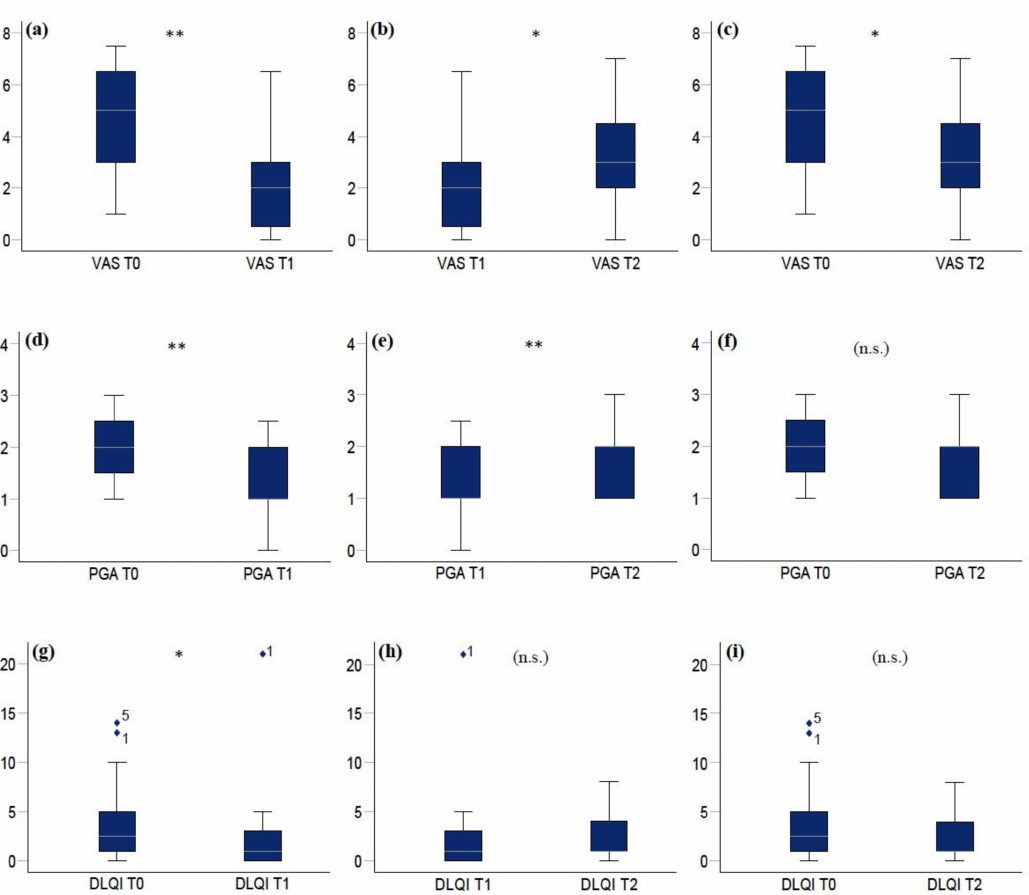
Figure 2. Boxplots depicting comparisons of VAS (visual analogue scale), PGA (physicians’ global assessment) and DLQI (Dermatology Life Quality Index) scores before CSA treatment (T0), after four weeks of treatment (T1) and after four weeks without treatment (T2). Upper row ( a – c ) VAS score: ( a ) T0/T1, ( b ) T1/T2, ( c ) T0/T2; middle row ( d – f ) PGA score: ( d ) T0/T1, ( e ) T1/T2, ( f ) T0/T2; lower row ( g – i ) DLQI score: ( g ) T0/T1, ( h ) T1/T2, ( i ) T0/T2. * p ≤ 0.05, ** p ≤ 0.01, (n.s.): nonsignificant.